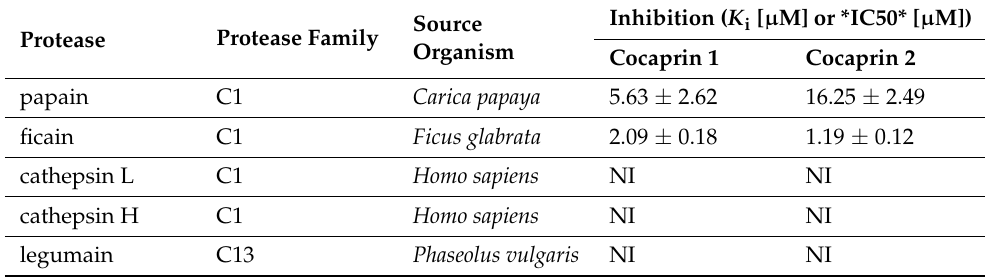
Table 2. Inhibitory pattern of cocaprins. Equilibrium constants ( K i ) for the inhibition of papain, ficain and pepsin were determined according to Henderson [27]. IC50 values are marked with astersks on both sides and indicated for rennin and APR1. Experiments were performed at 30 ◦ C. S.D. are